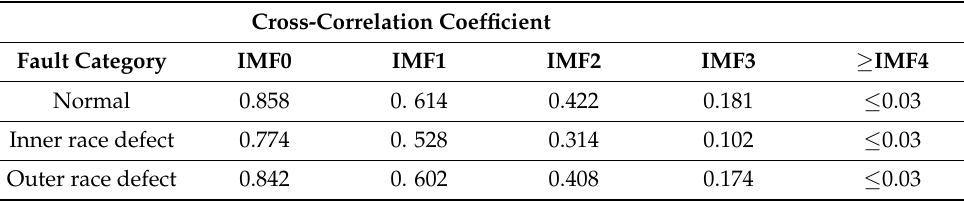
Table 2. Cross-correlation coefficient between IMF sub-signal and original signal of each fault.